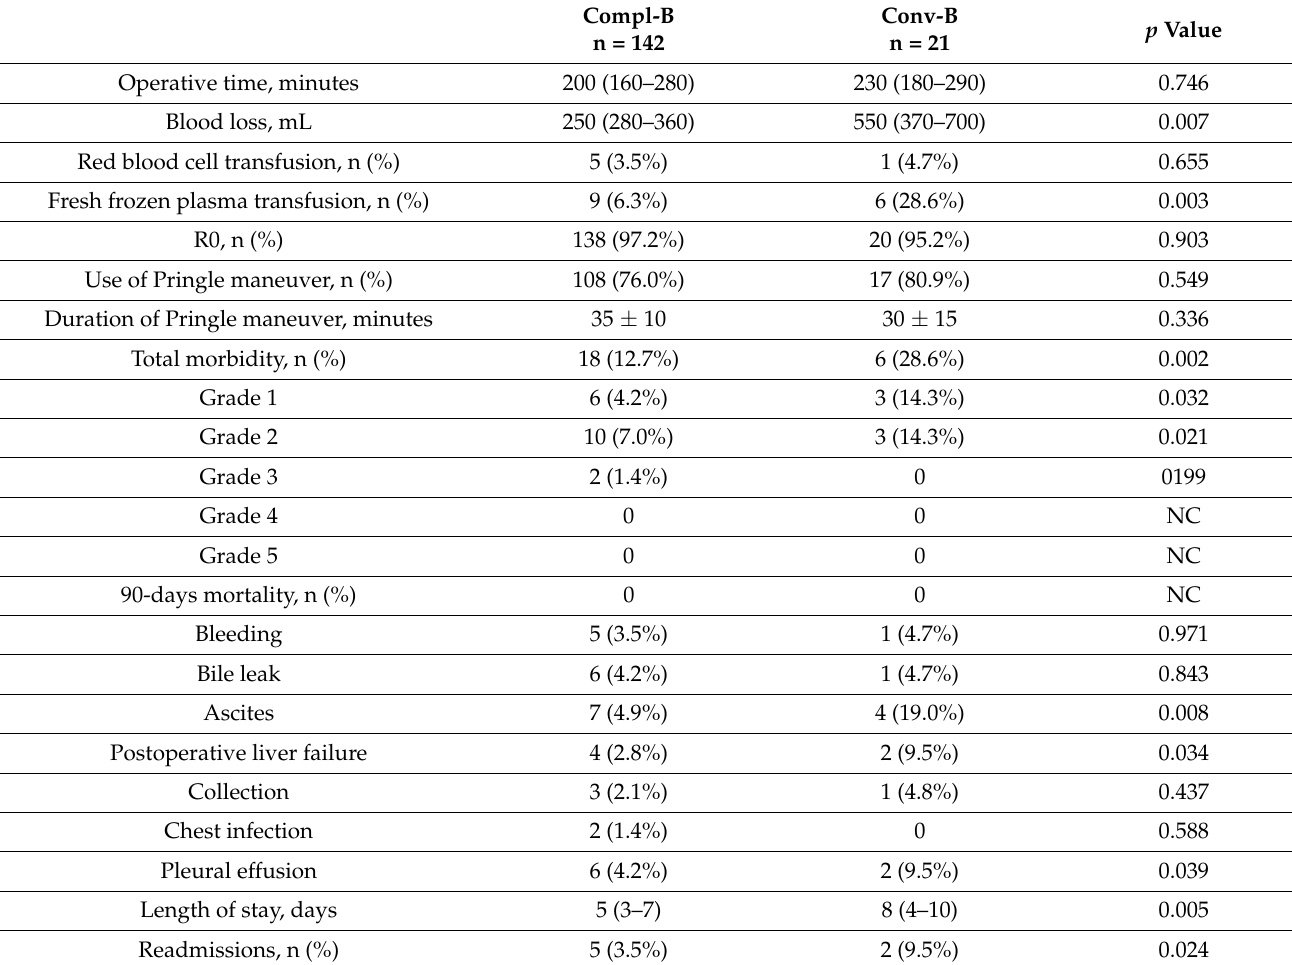
Table 4. Results of completed versus converted MILRs for HCC in advanced cirrhosis patients (Child B and Child A/B with portal hypertension). Compl-B n = 142